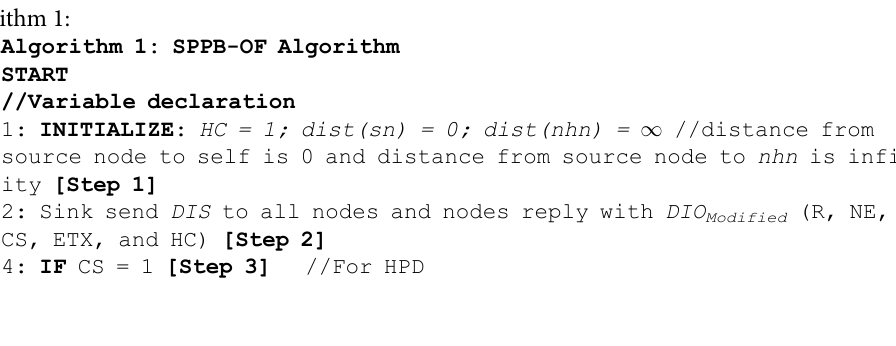
Algorithm 1: SPPB-OF Algorithm